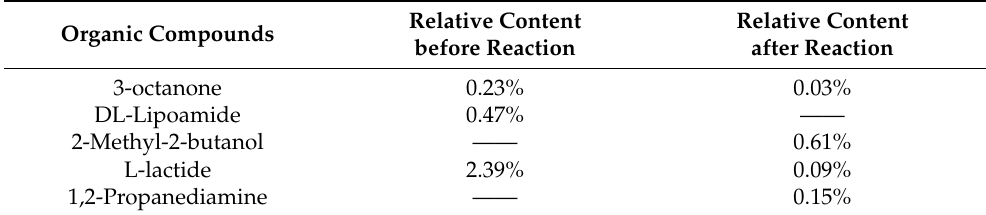
Table 4. GC–MS results before and after anaerobic DPAT treatment.